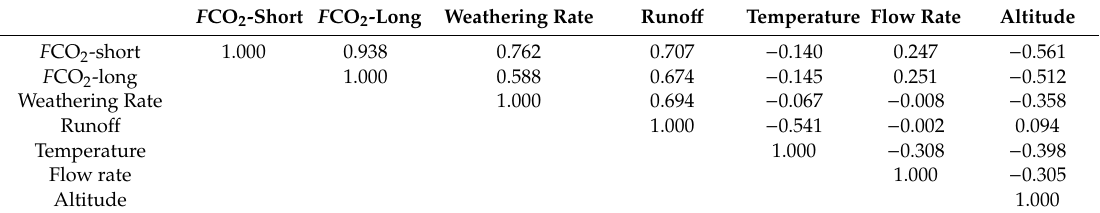
Table 5. Pearson correlation matrix of F CO 2 (fluxes of atmospheric carbon dioxide consumed by weathering in the short and long term), weathering rates and controlling factors: runo ff , temperature, flow rate, and altitude.